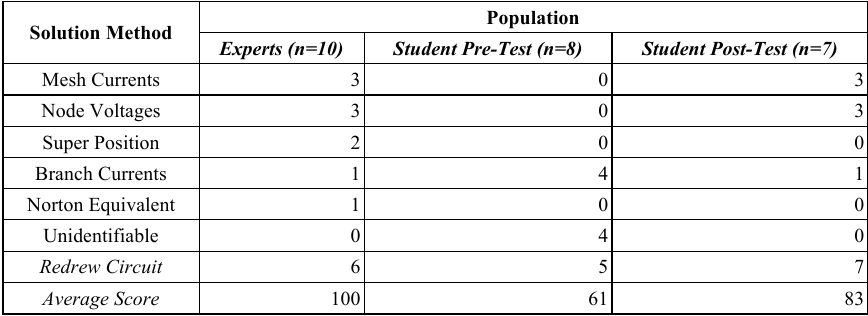
Table 6. Solution methods to quantitative